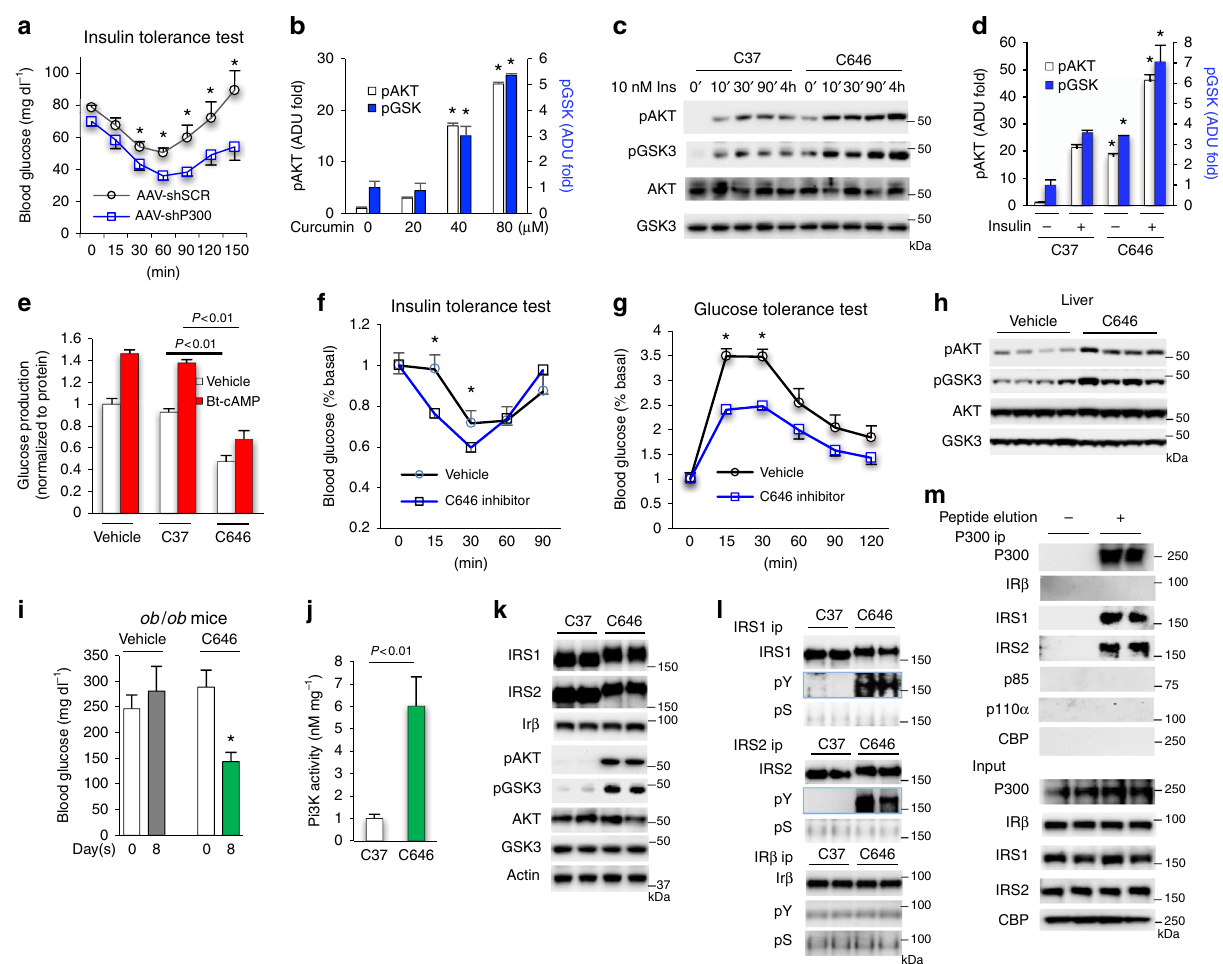
Fig. 6 Inhibition of P300 acetyltransferase activity improves insulin signaling. a After injection of AAV8-shRNAs for SCR or P300 via jugular vein, mice were fed on an HFD for 3 weeks, insulin tolerance test (6 h fasting, 0.5 unit per kg) was conducted ( n = 5). b Densitometric analysis of the pAKT and pGSK3 in cells treated with curcumin as in Supplementary Fig. 5a. c , d Hepa1-6 cells were treated with 20 μ M control C37 or inhibitor C646 for 1 h before the addition of 10 nM insulin (~4h). Densitometric analysis of the pAKT and pGSK3 in hepatocytes treated with insulin for 4 h ( n = 3) d . e 16 h after the planting of primary hepatocytes, vehicle (DMSO), C37 and C646 (20 µ M) were added to medium during serum starvation. After washing with PBS, above agents and 0.2 mM Bt-cAMP were added in glucose production medium ( n = 3). f , g 2 weeks after being fed on an HFD, mice were given either the vehicle or inhibitor C646 (15 nmolg − 1 ) via intraperitoneal injection for 2 weeks, insulin tolerance test (4 h fasting, 0.6 unit kg − 1 , n = 4 – 5) and glucose tolerance test (4 h fasting, 1.5 g kg − 1 , n = 4 – 5) were conducted. h Liver tissues from HFD-fed mice were collected after 16 days of treatment with vehicle or inhibitor C646. Each lane represents a mouse sample. i Blood glucose levels (6 h fasting) in ob/ob mice treated with vehicle or inhibitor C646 (30 nmol g − 1 ) for 8 days ( n = 5). j Hepa1-6 cells were treated with 5 µ M C37 or inhibitor C646 for 4 h. Pi3k P110 α was immunoprecipitated ( n = 3). k , l Hepa1-6 cells were treated with 20 µ M C37 or inhibitor C646 for 4 h in DMEM without foetal bovine serum. m Liver lysates from mice fed an HFD (3 weeks) were incubated with P300-speci fi c antibody and protein G beads overnight, washed, then incubated with peptide used to generate P300 antibody for 2 h. Each bar represents the mean ± s.e.m. *, P < 0.05, paired sample t -test between